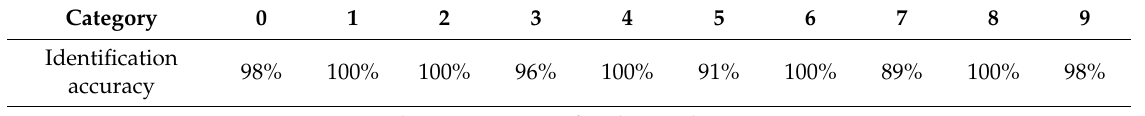
Figure 10. ( a ) Test accuracy; ( b ) train loss.